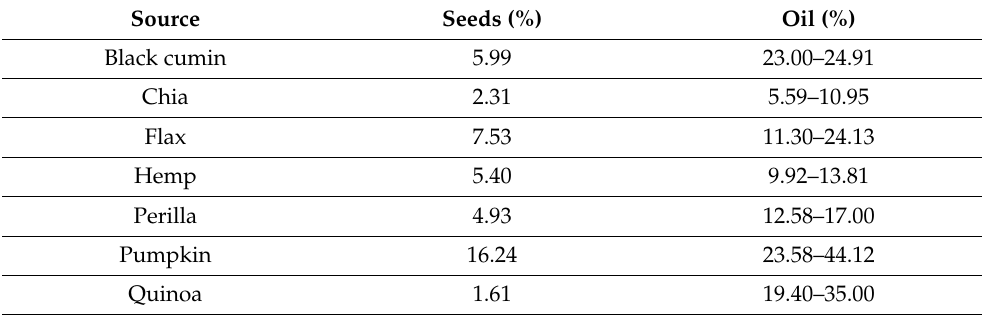
Table 4. The common types of MUFAs in different types of seeds (per 100 g) and in extracted oil